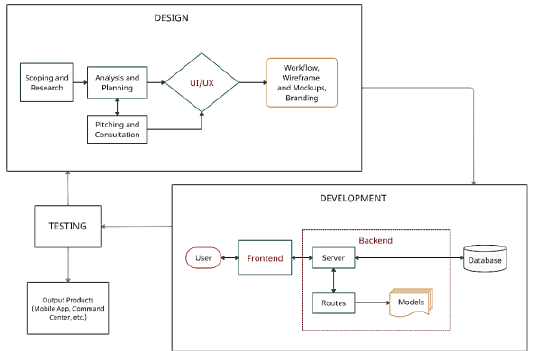
Figure 1. General Process Flow for City Connect Design and Development